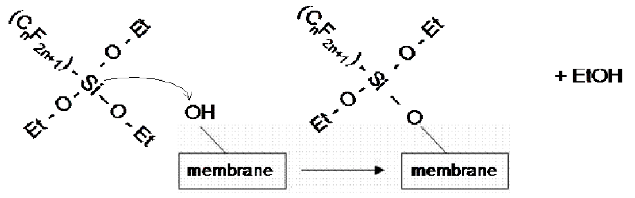
Figure 4. The structure of hydrophobic coating deposited to the membrane by